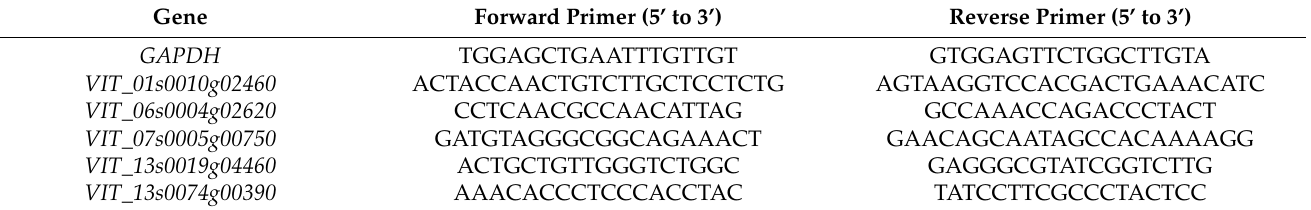
Table 1. Primers for real-time PCR.